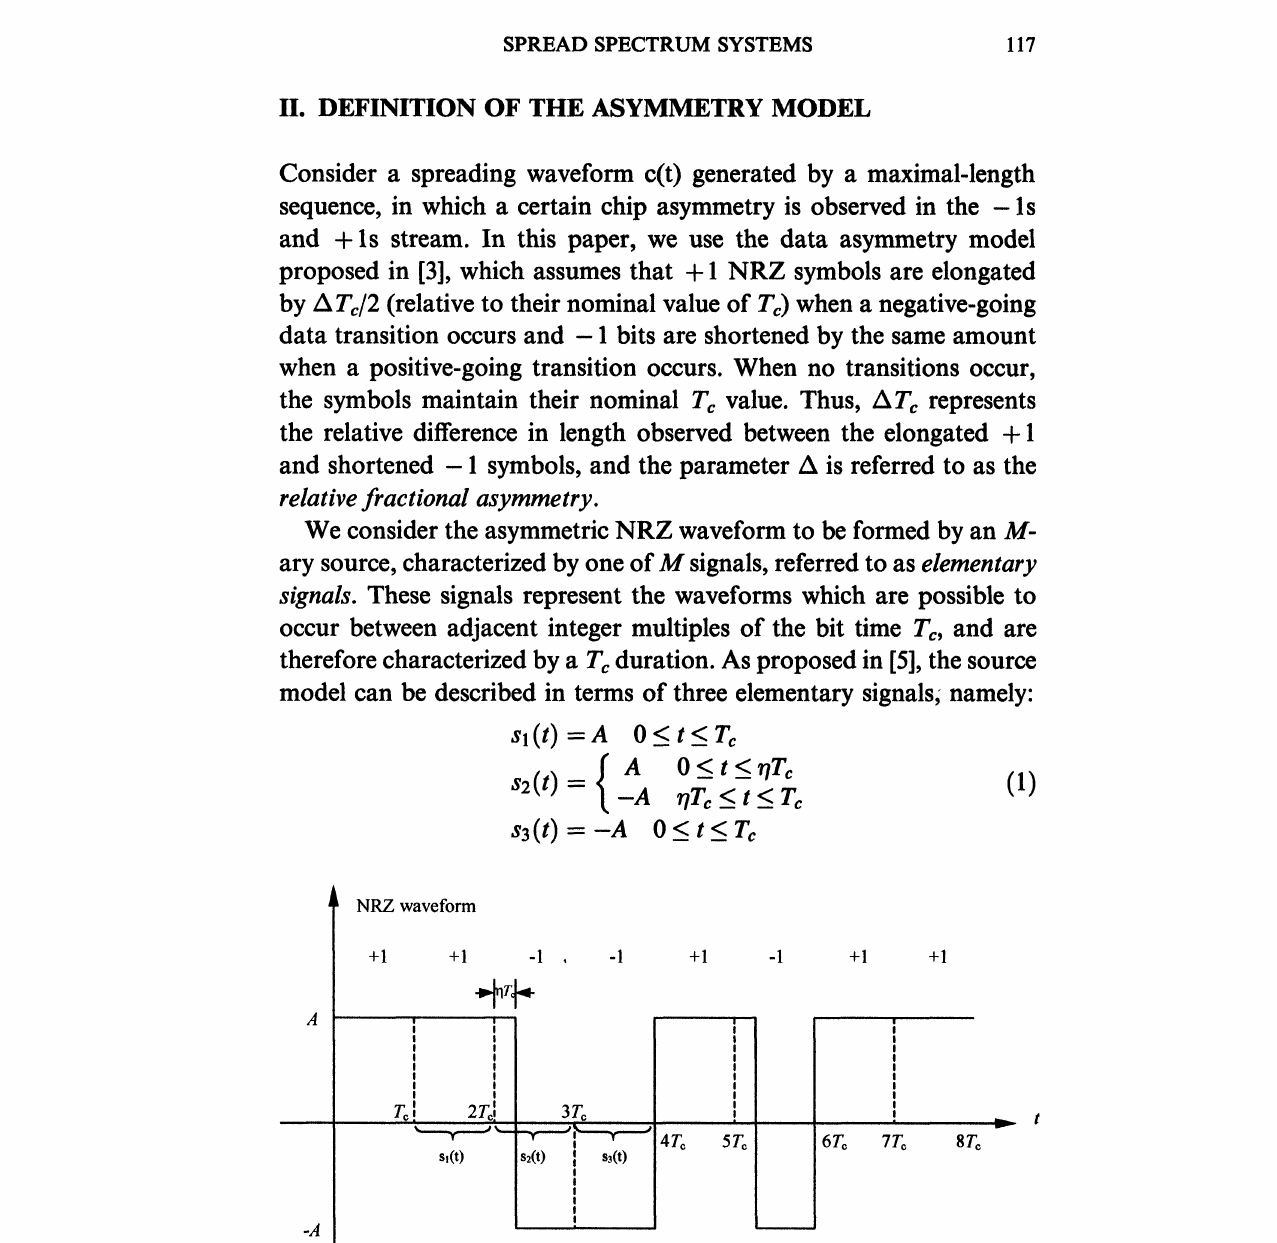
FIGURE Unbalanced asymmetric waveform for a typical data